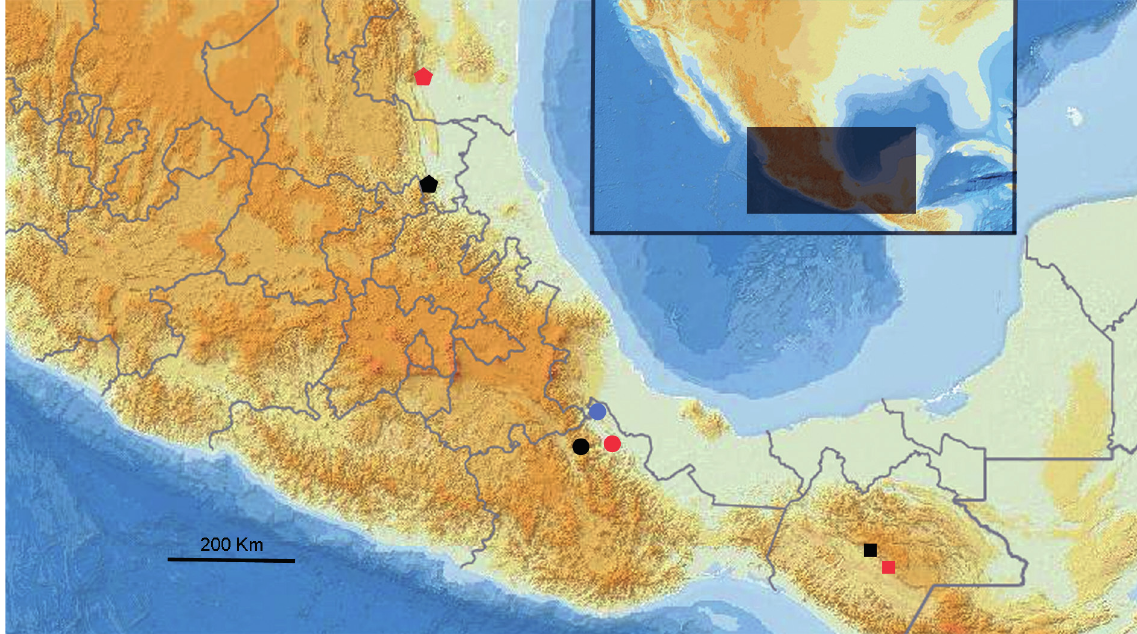
Fig. 8. Distribution of selected troglobitic genera of Stygnopsidae Sørensen, 1932. Squares are distribution of Troglostygnopsis Šilhavý, 1974: black = T. anophthalma Šilhavý, 1974; red = T. kalebi sp. nov. Circles show distribution of Brujita Cruz-López, in press, Toojah Cruz-López, in press and